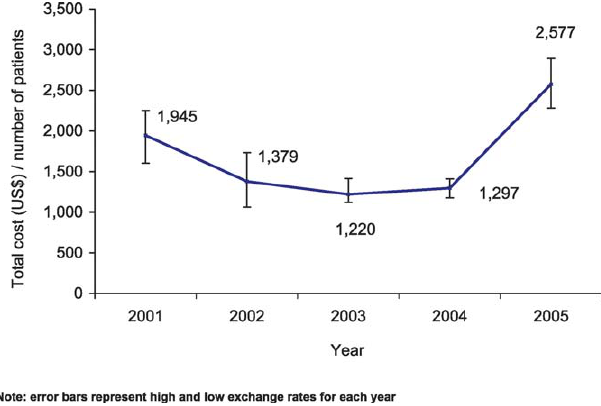
Figure 3. Ratio of Total Annual ARV Costs in US Dollars to Numbers of Patients on Treatment